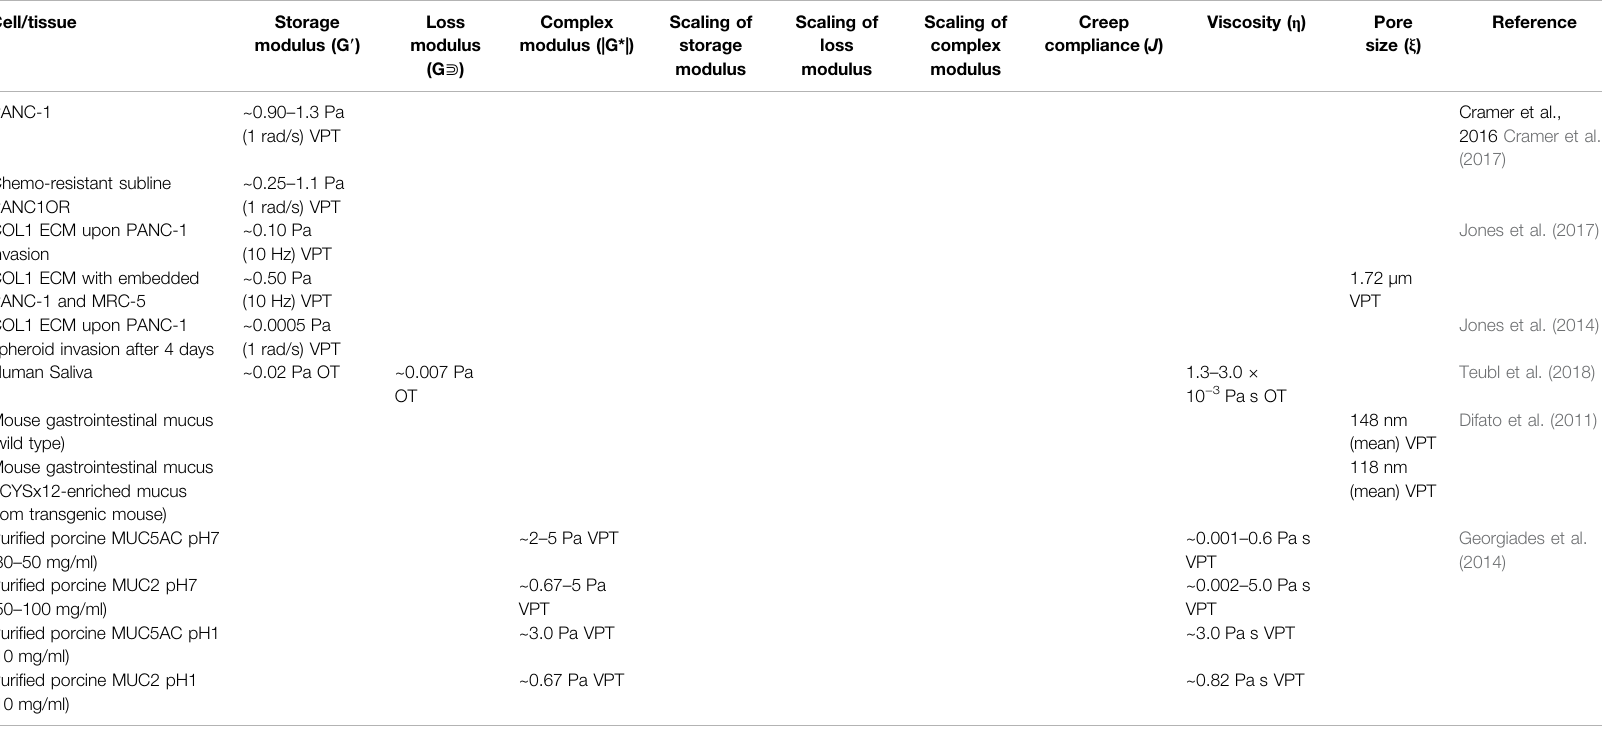
TABLE 2 | Microrheological properties of mammalian cells and tissue of the digestive system measured by various microrheological